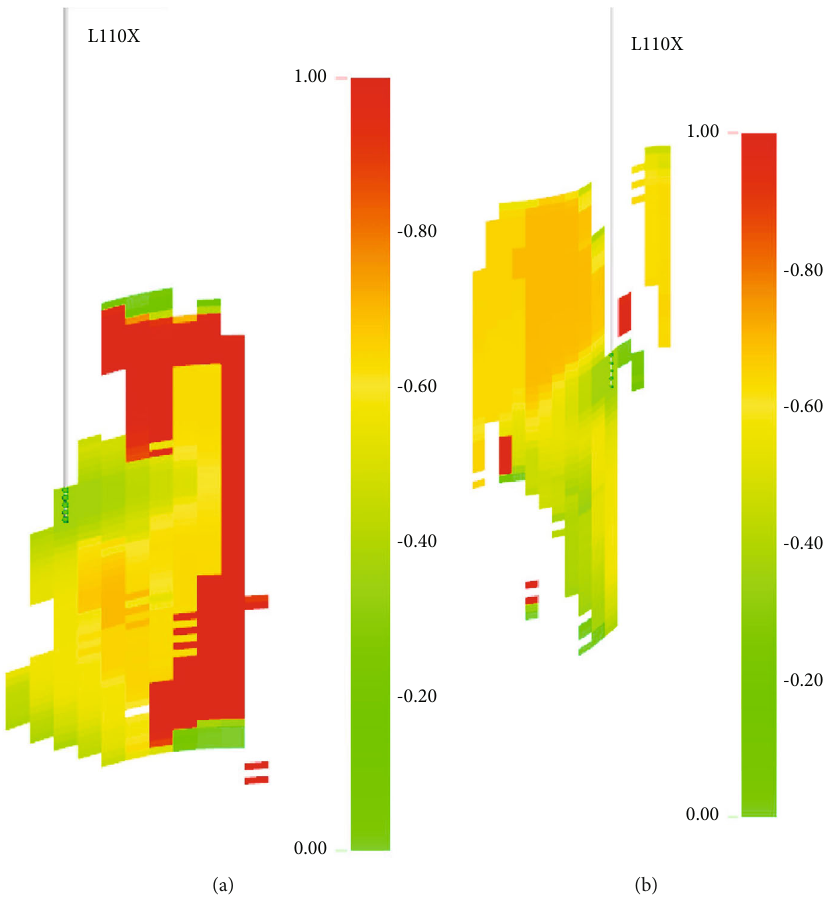
Figure 9: Residual oil distribution characteristics in the L110X